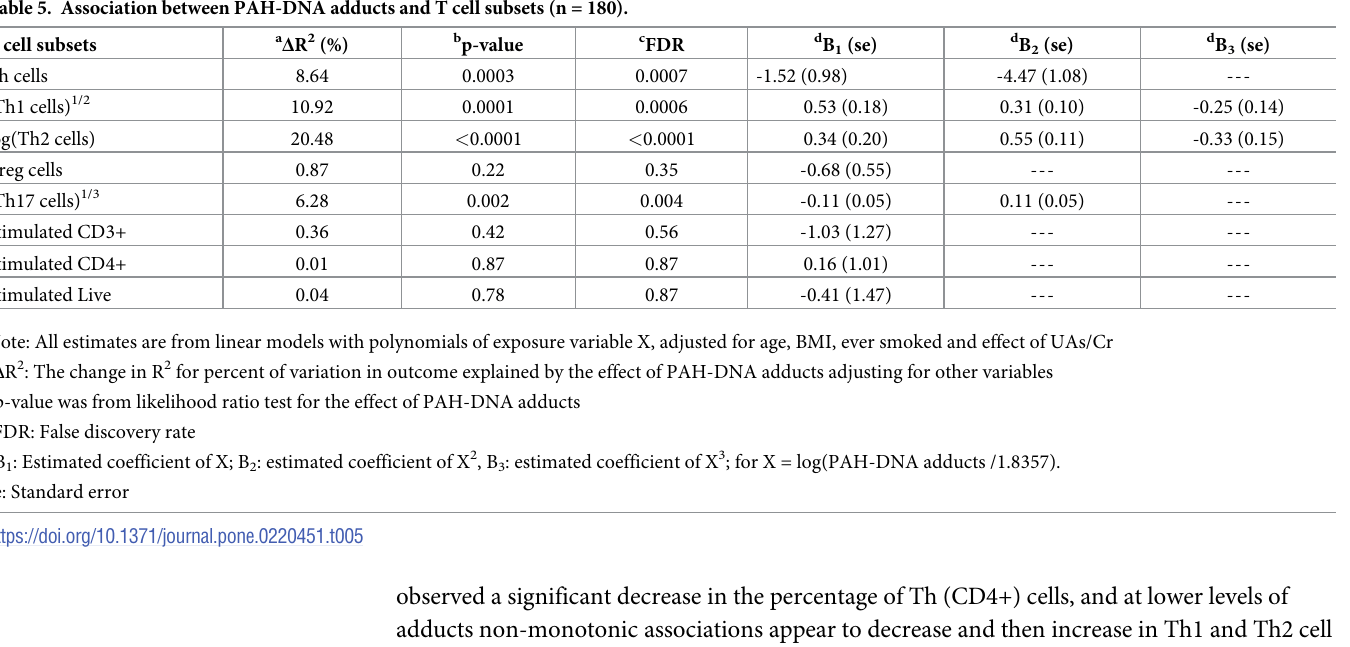
observed a significant decrease in the percentage of Th (CD4+) cells, and at lower levels of adducts non-monotonic associations appear to decrease and then increase in Th1 and Th2 cell populations. These findings demonstrate the complexity of the effects that As and PAH have on the immune system. The non-monotonic associations of As and PAH further complicate interpretation of findings in co-exposures.